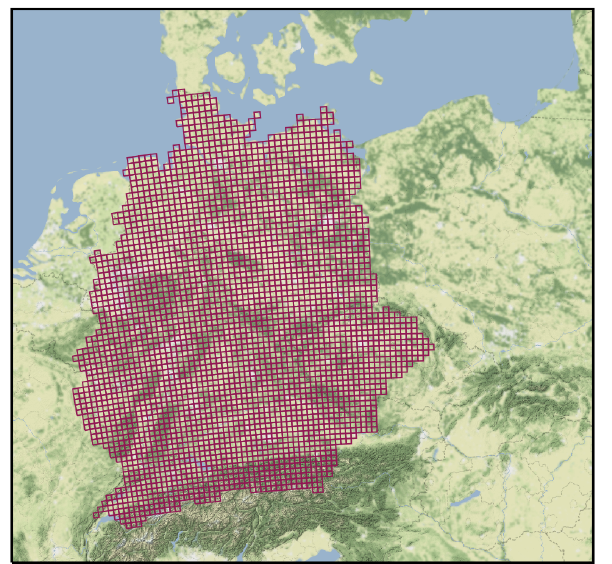
Figure 1. EURO-CORDEX grid cells used for the analyses – the ReKliEs-De area. It includes Germany and several catchments of rivers discharging into